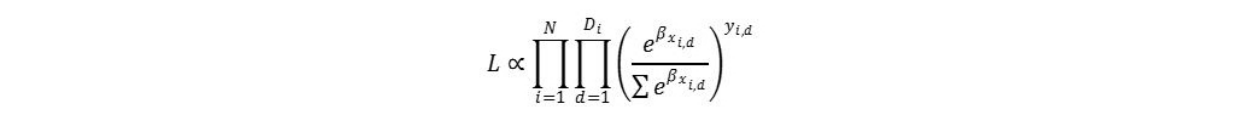
Figure 3. Self-controlled case series (SCCS) maximum likelihood